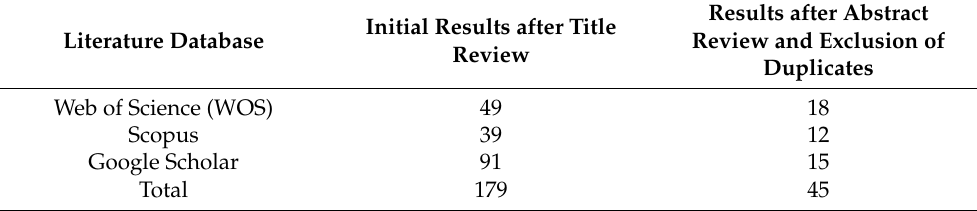
Table 1. Review process of the selected articles.